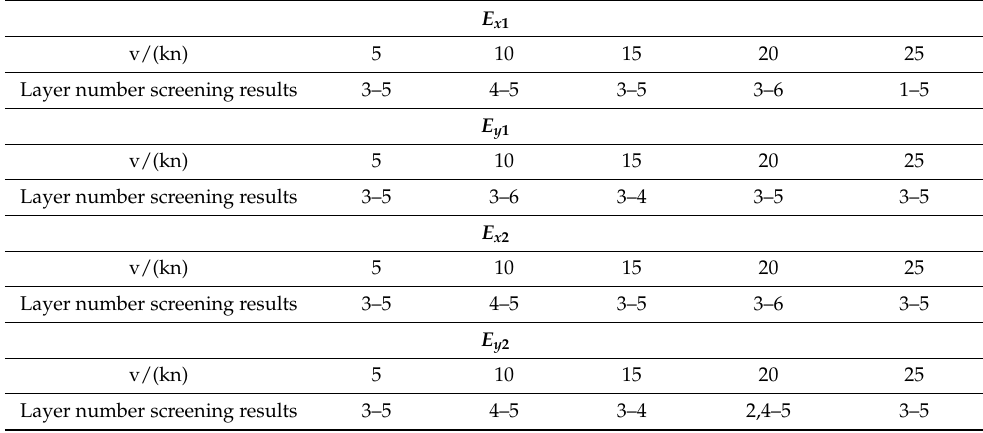
Table 4. Screening results of IMF layers with target noisy signals collected by different sensors at different